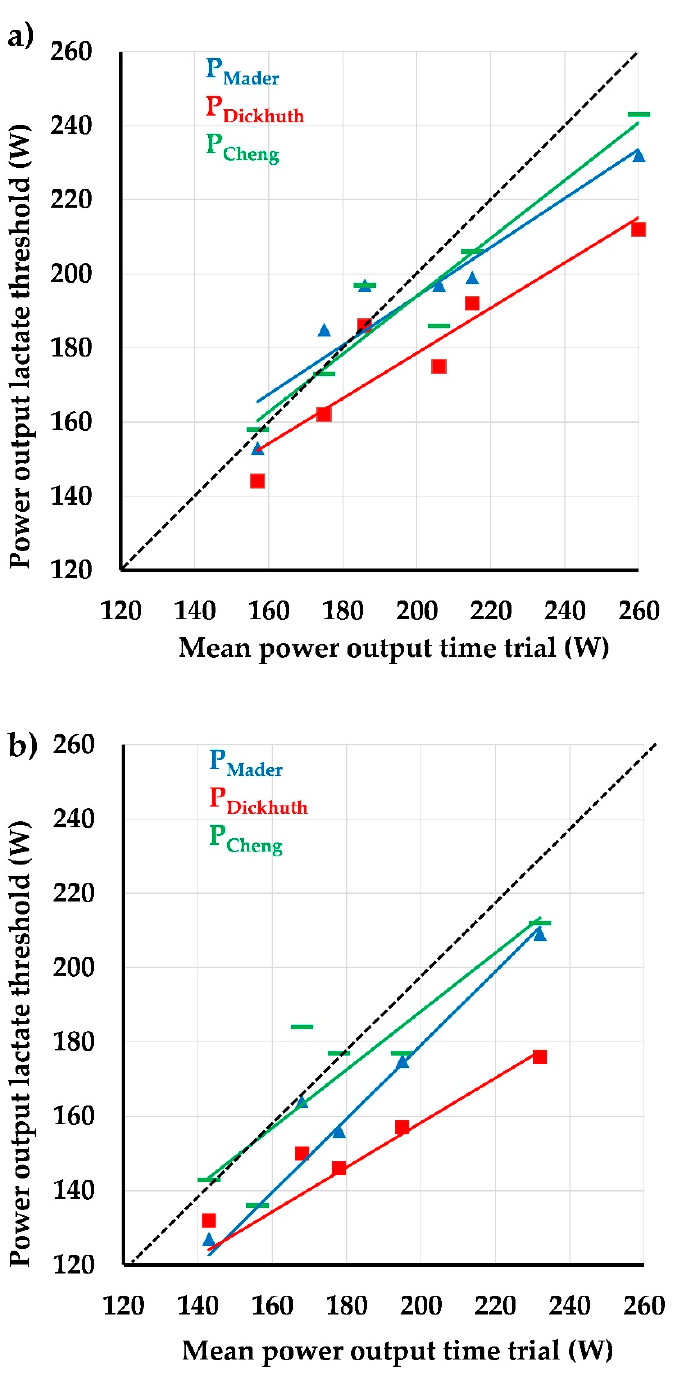
Figure 2. Association between mean power output during the time trial and power output at three different lactate thresholds (blue = P Mader , red = P Dickhuth , green P Cheng ) [11–13]. Data are presented for normoxic (upper panel) und hypoxic conditions (lower panel). ( a ): normoxic conditions; ( b ): hypoxic conditions Comparing hypoxia-related impairments in power output at the three LT and in P mean, significant differences were found for P Mader and P Dickhuth but not for P Cheng (Figure 3).